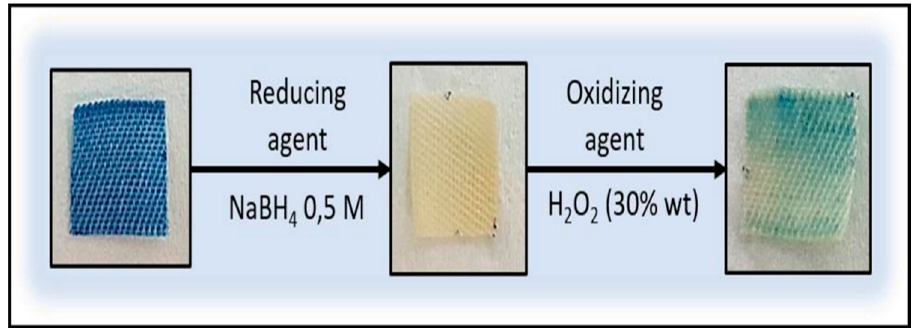
Figure 3. Reversibility assays in the textiles, using as reducing agent NaBH 4 0.5 M and as oxidizing agent H 2 O 2 (30%